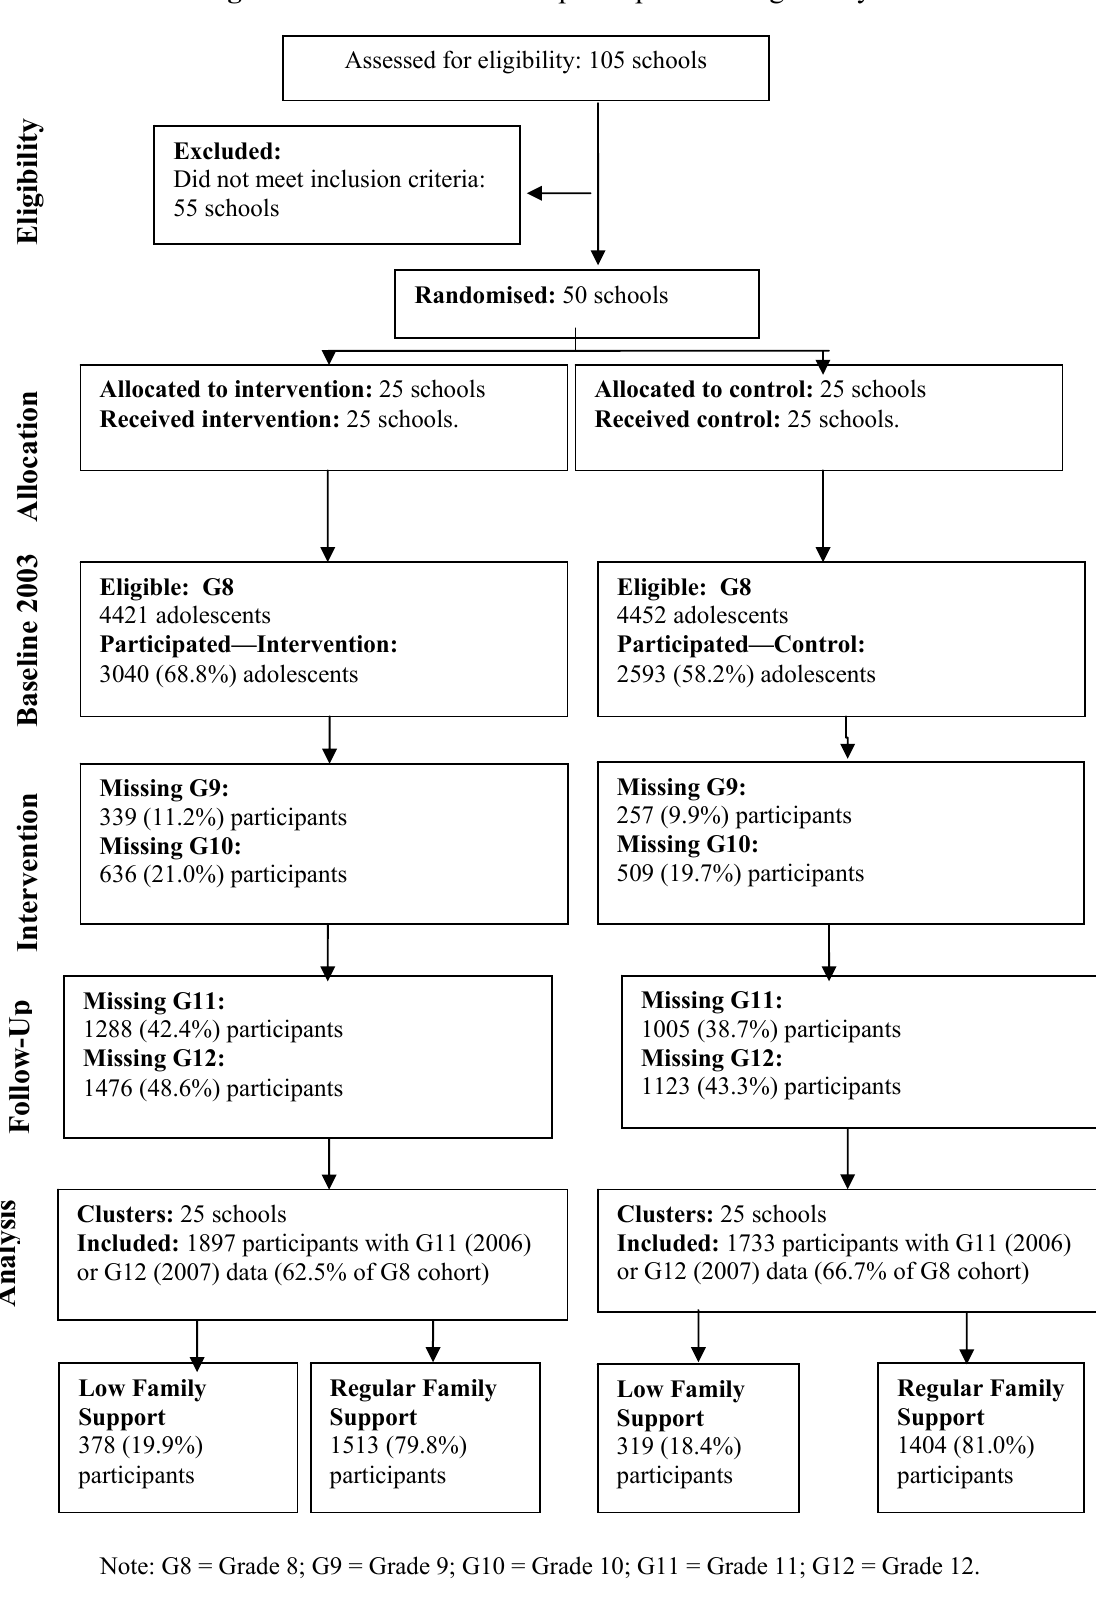
Figure 1. Flow of adolescent participants through